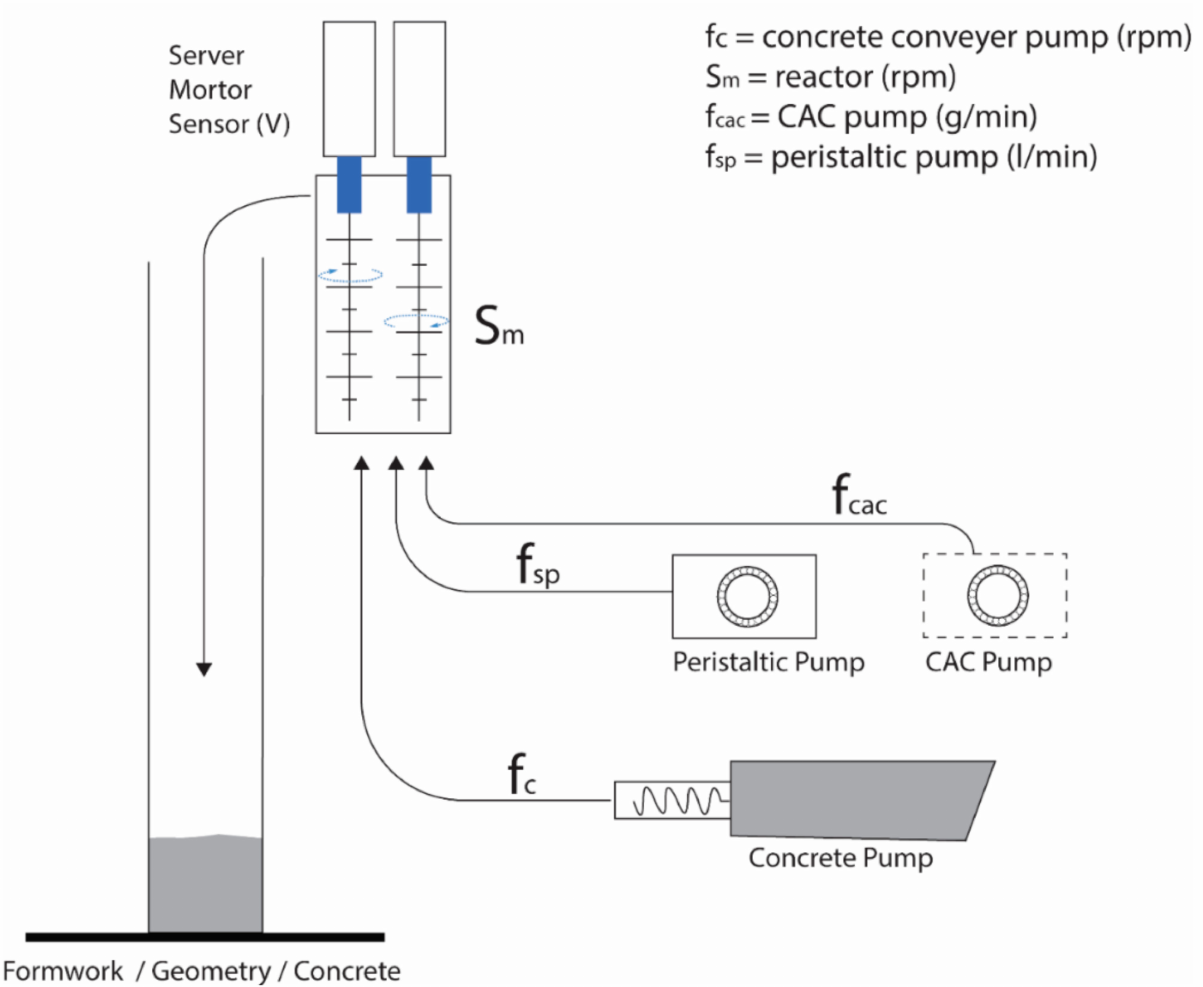
Figure 3. Schematic illustration of pumps and components in the digital casting setup processing system. After several developments on a prototypical level, we settled for the final design depicted in Figure 4. This consists of a vertical chamber designed as a closed (not pressur- ized) constantly stirred reactor (CSTR). The mixing chamber (a) has a volume of ± 3 L. It contains two vertical pins (b) rotating in opposite directions, each with three pins and one paddle stirred by server motors (b1). On each paddle, a rubber is mounted to assure that no material is attached to the wall of the chamber. The spacing between the pins is 3-times larger than the larger aggregate size so the concrete can flow through easily. The retarded concrete is pumped continuously into the CSTR from the bottom (d) and flows out at the top of the mixer (e) into a formwork. The accelerator and flow enhancers are dosed into the chamber through (c). The system allows for a variable flow rate between 1.5 L/min and 3 L/min. These values are based on studies that indicate an optimal residence time com- bining good mixing with limited thickening of the mix. The control software synchronizes the concrete pump flow rate (f c ) with the dosing speeds of the peristaltic pump (f sp ) and the accelerating admixtures pump (f cac ) to ensure constant dosage of the mix components using a customized software based on